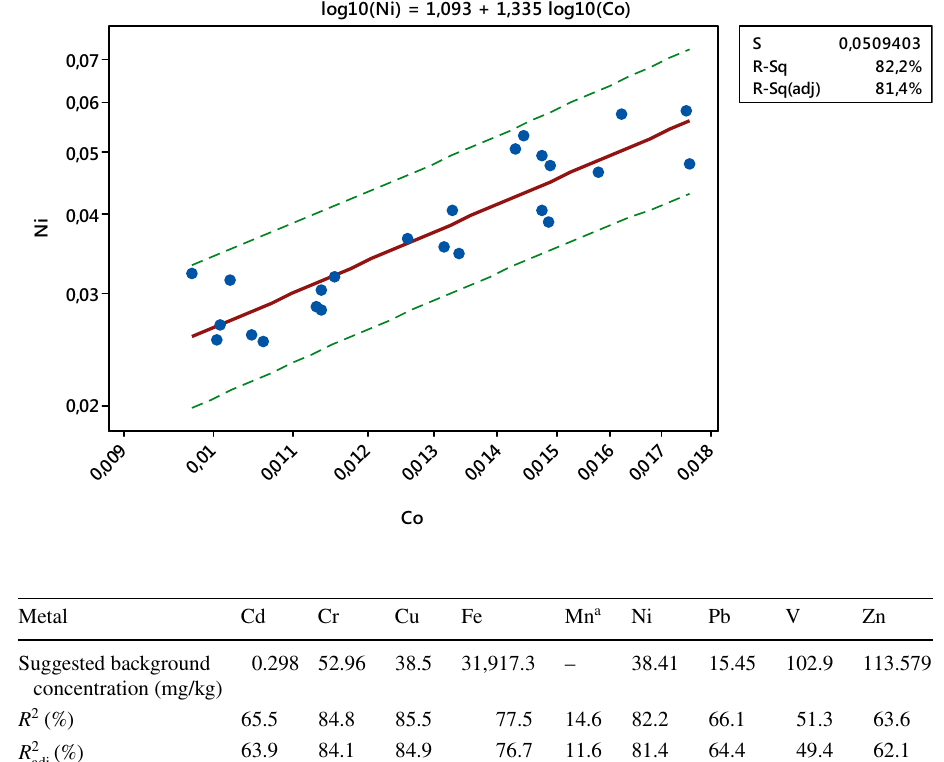
Fig. 10 Linear regression graph of nickel background concentra- tion determination ( R 2 = 82.2%)